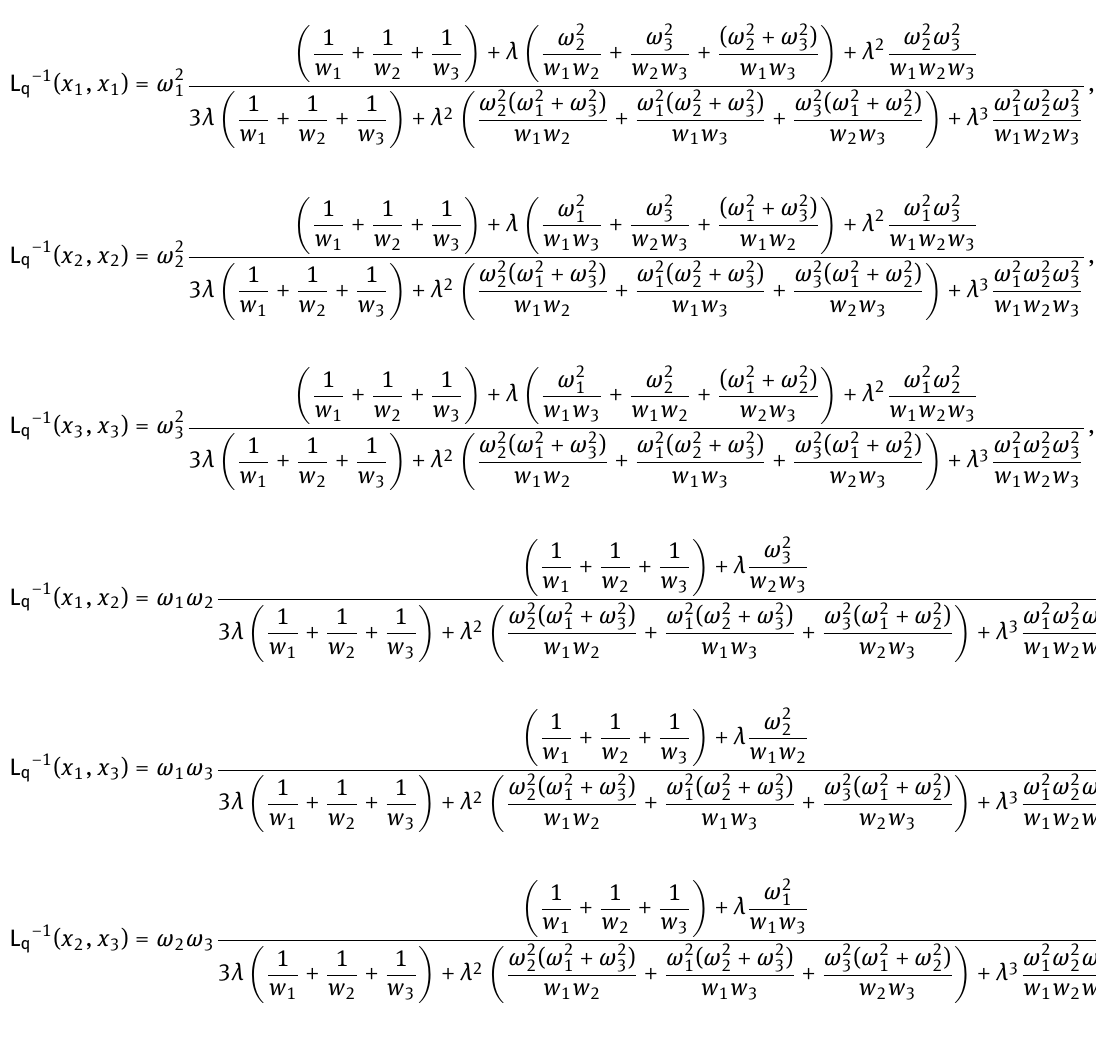
Figure 9: The collection of 3 -rooted forests for K 3